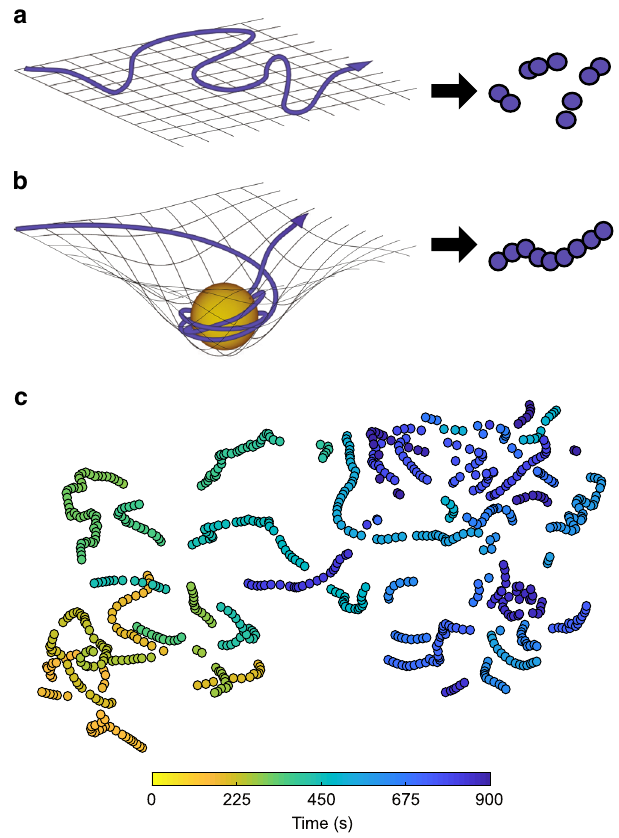
Fig. 1 Network space representation. a Continuous, random passage through the space of possible network con fi gurations generates fragments in t -SNE space, as opposed to b contiguous, worm-like segments when an attractor holds network con fi gurations in relative meta-stability. c An example reduced t -SNE representation involving both segment types, as observed from one participant ’ s 15-min rs-fMRI scan. Here, the color gradient conveys progression through time from 0 to 900